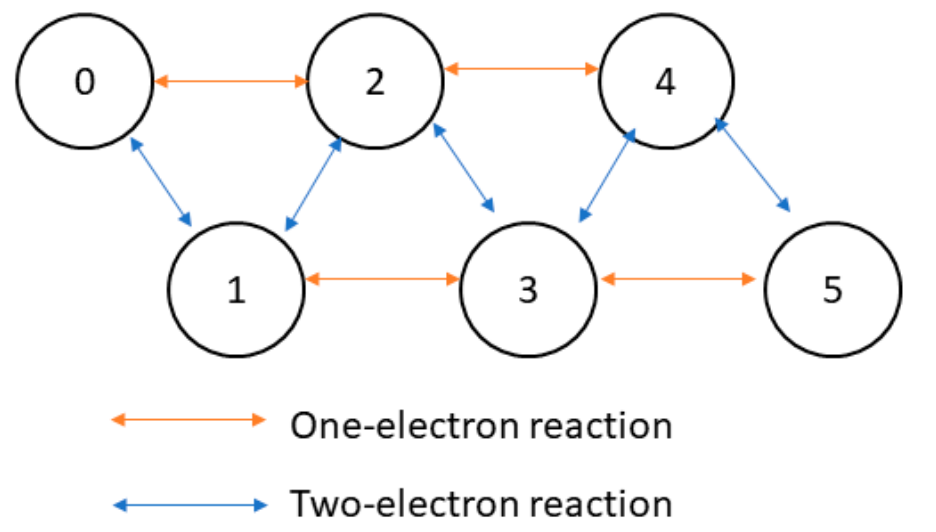
Figure 7. Schematic of the dimeric complex III model by Bazil et al. [99]. The 6 states represent the number of electrons in complex III. The model includes one-electron transfer reactions (orange arrows): ubiquinol oxidation at the Qo site (one electron goes to heme bL, the other goes through ISP, cytochrome c1, and finally to cytochrome c) as well as oxygen reduction to superoxide. The model also has a two-electron transfer reaction: Q reduction at the Qi site. The figure was reprinted/adapted from Ref. [99] .